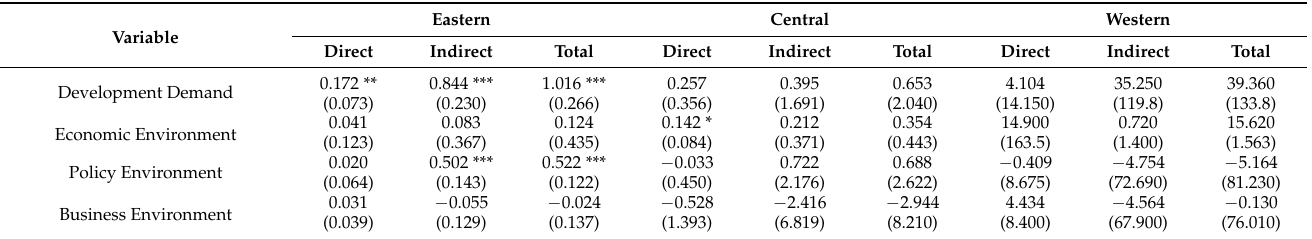
Table 7. Direct, indirect, and total effects of the SDM in the eastern, central, and western regions of China (source: authors’